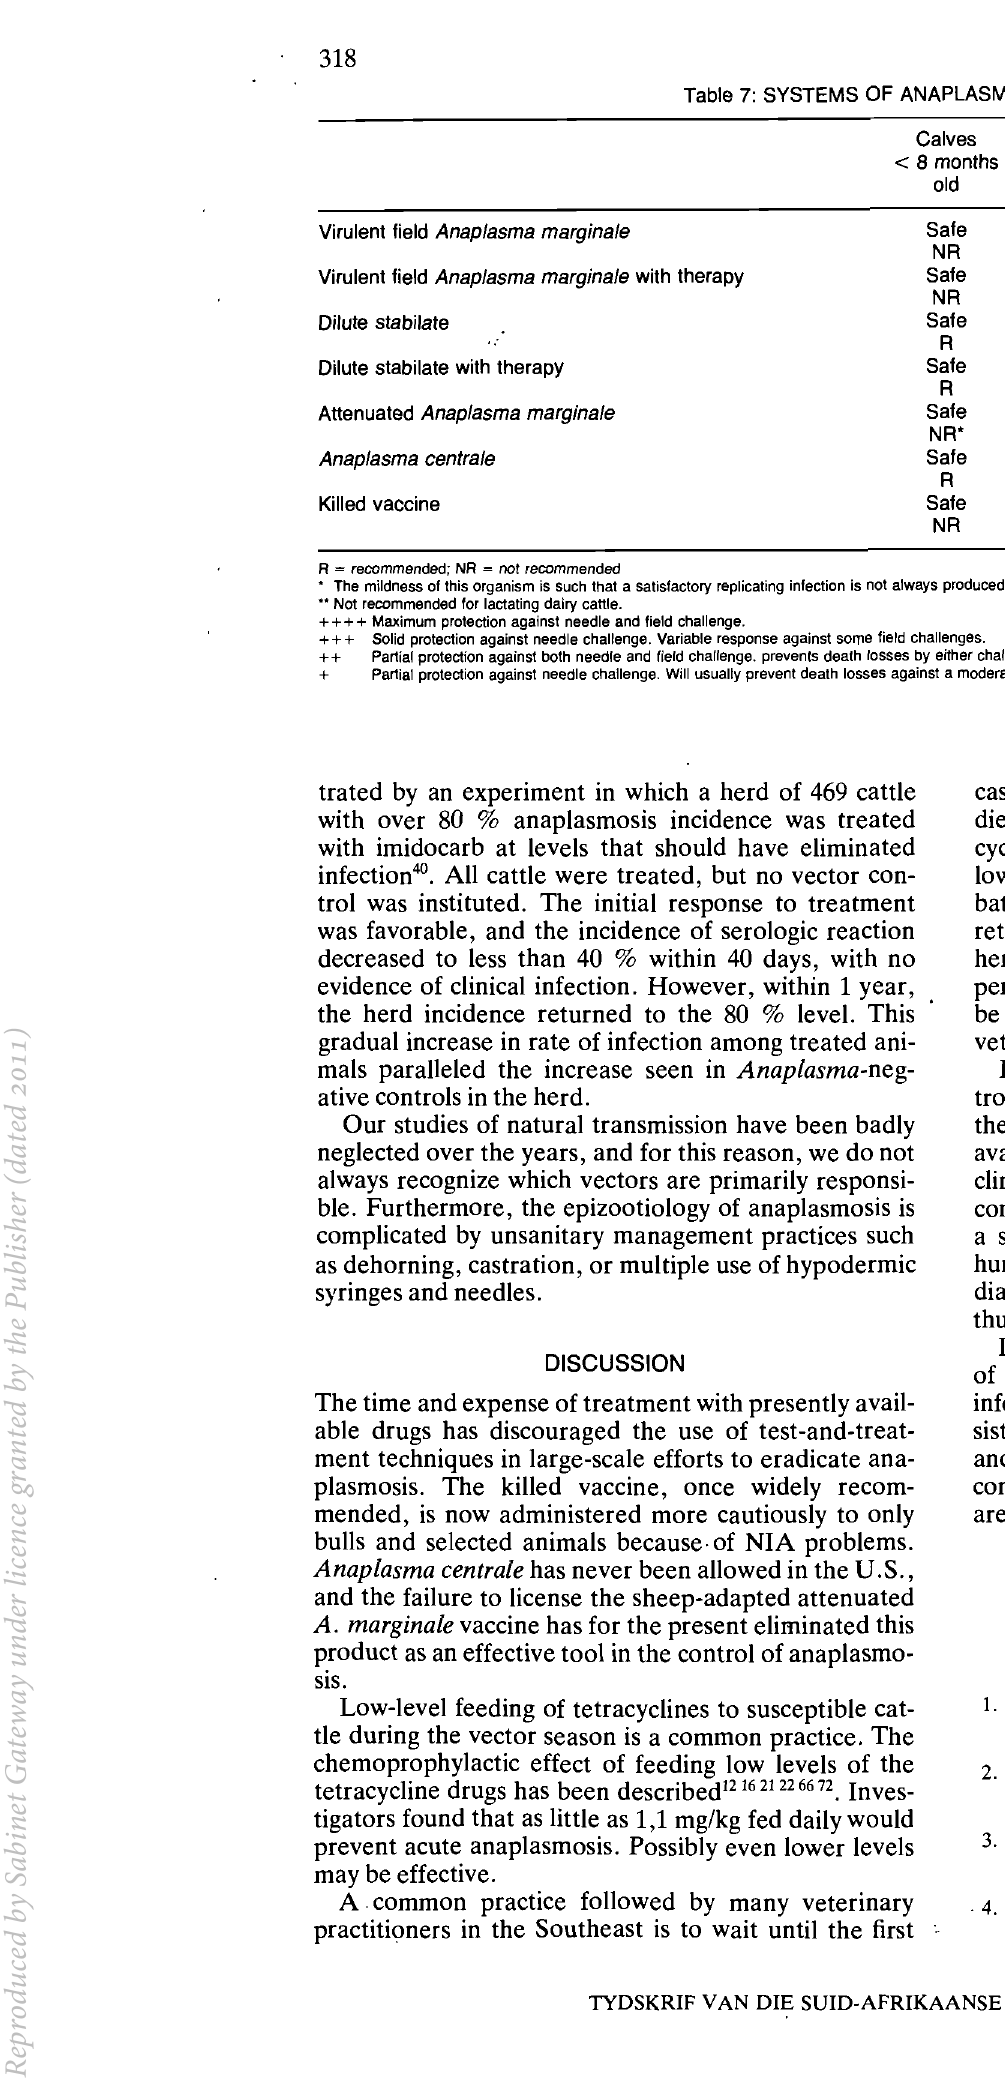
nation Test for Bovine Anaplasmosis: Evaluation with